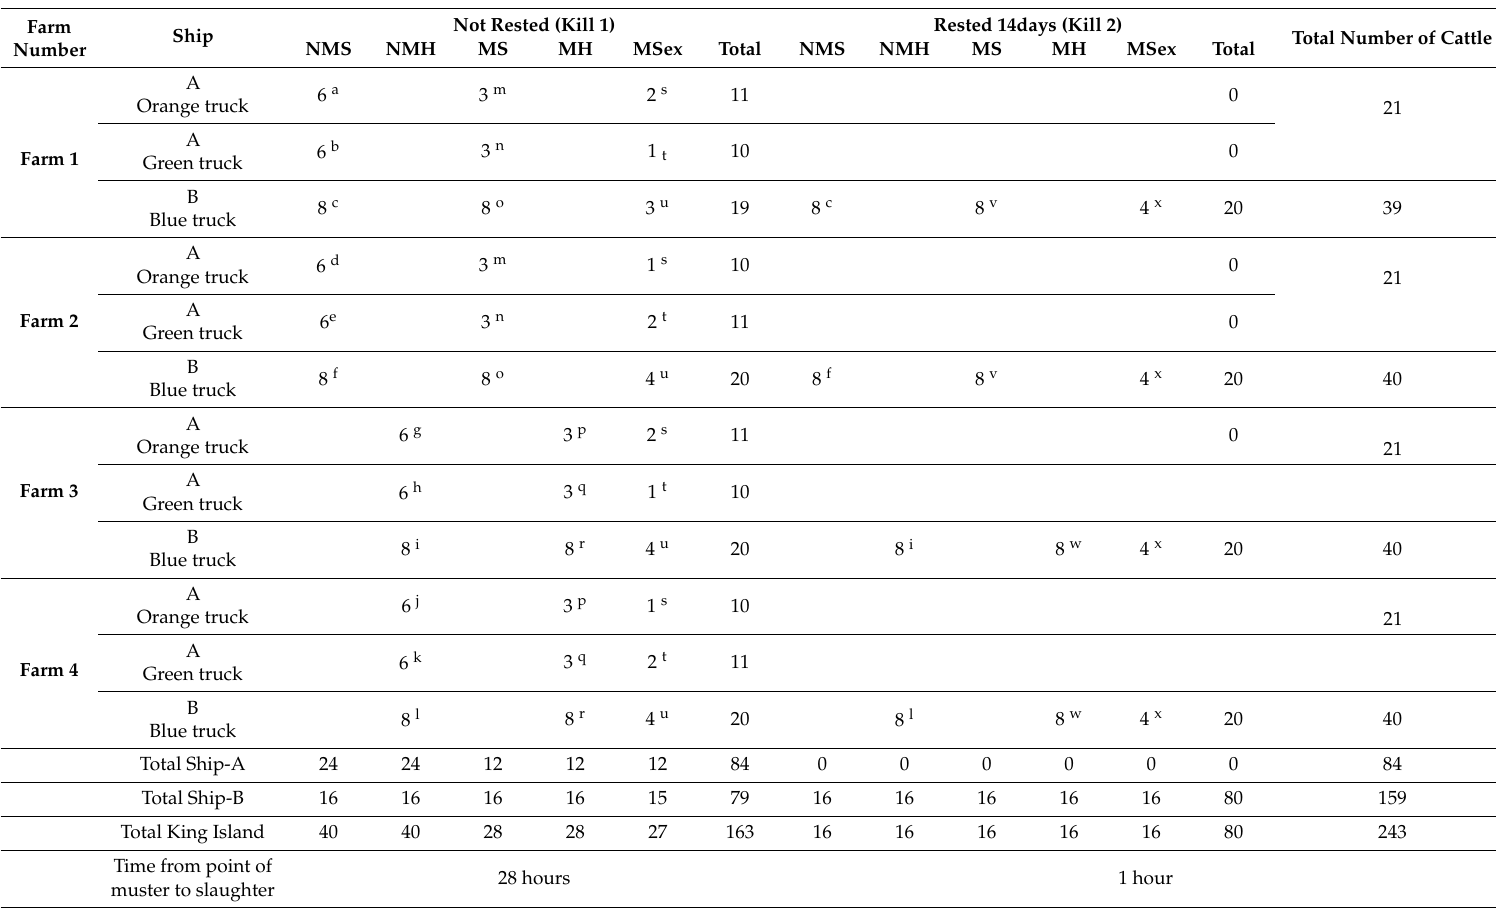
Table 1. Experiment One. Number of cattle by location, farm, mixing, transport and slaughter interval (Total slaughter count. Excludes those eliminated from the trial). Superscripts “a-x” demonstrate common groups during transport and